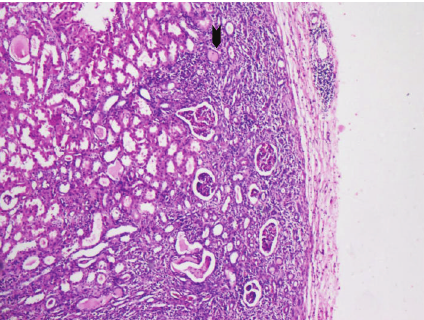
Figure 2: Microscopic section of the kidney showing features of chronic pyelonephritis with dense interstitial inflammatory infiltrate and atrophic tubules (arrow head). (H&E, × 10).